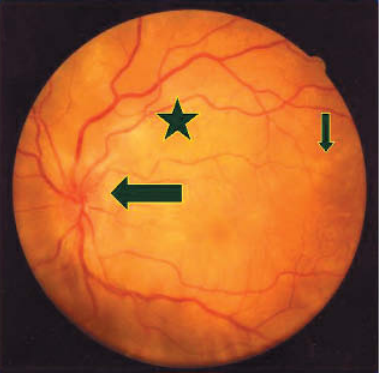
Figure 1. Fundal Appearance of the Patient’s Eye The large arrow indicates the pink optic nerves; the star shows localised retinal detachment; and the small arrow pointing down shows small, white choroidal granulomas.